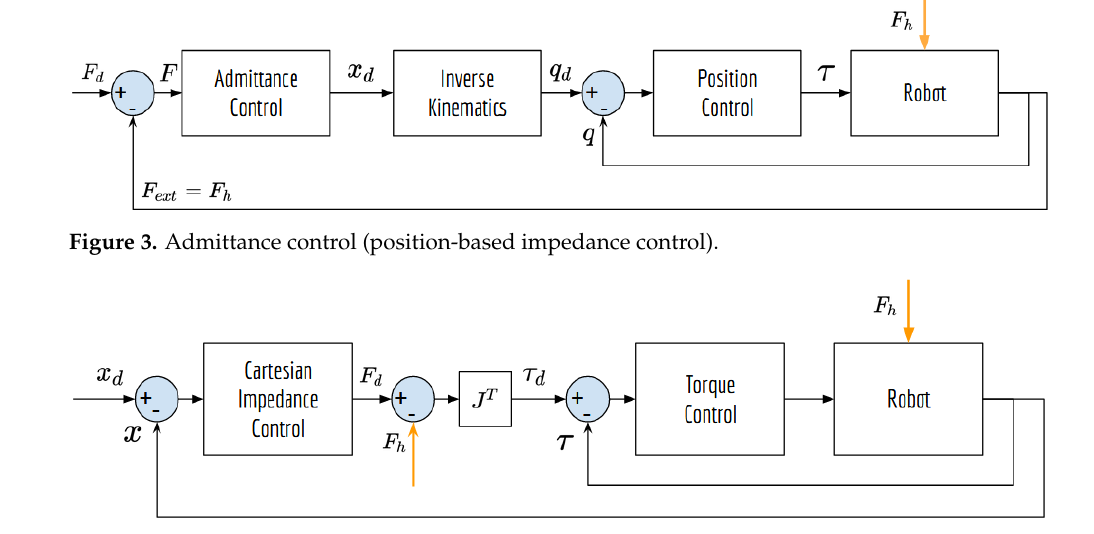
Figure 4. Torque-based impedance